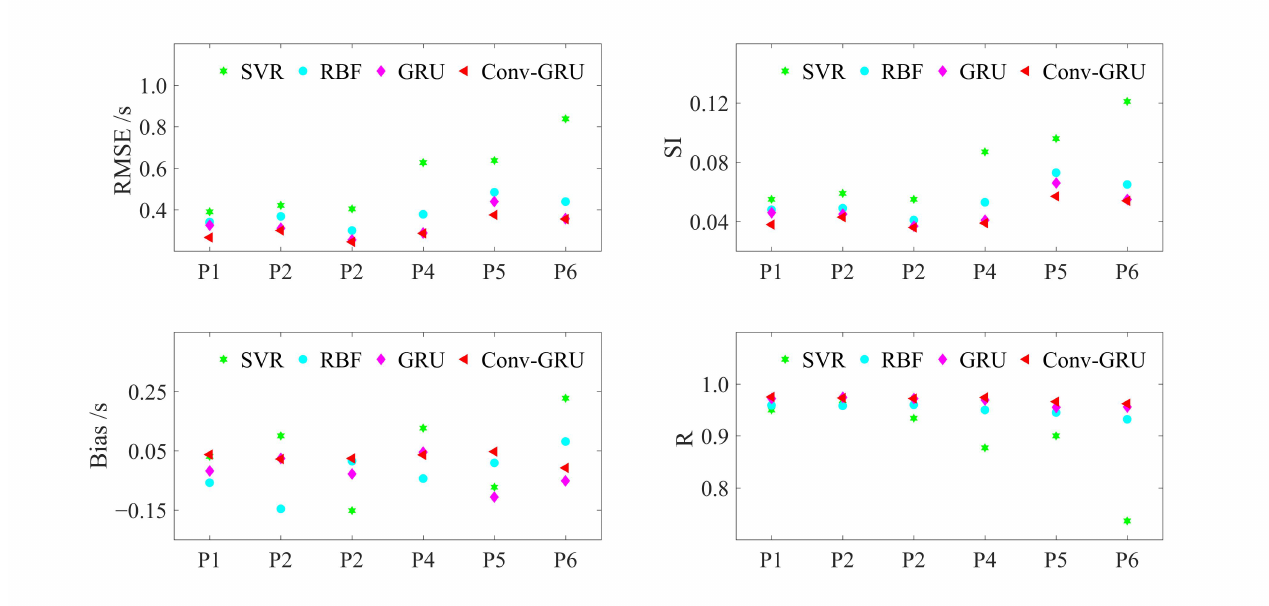
Figure 7. Performance of the SVR, RBF, GRU, and Conv-GRU models. Table 4 lists the statistical properties of the GRU and Conv-GRU models. The numeri- cal results show that the models have different perturbation and forecasting ability for the six points, and the performance of GRU is inferior to Conv-GRU. Table 4. Six points of performance at different lead times in the Conv-GRU (GRU)